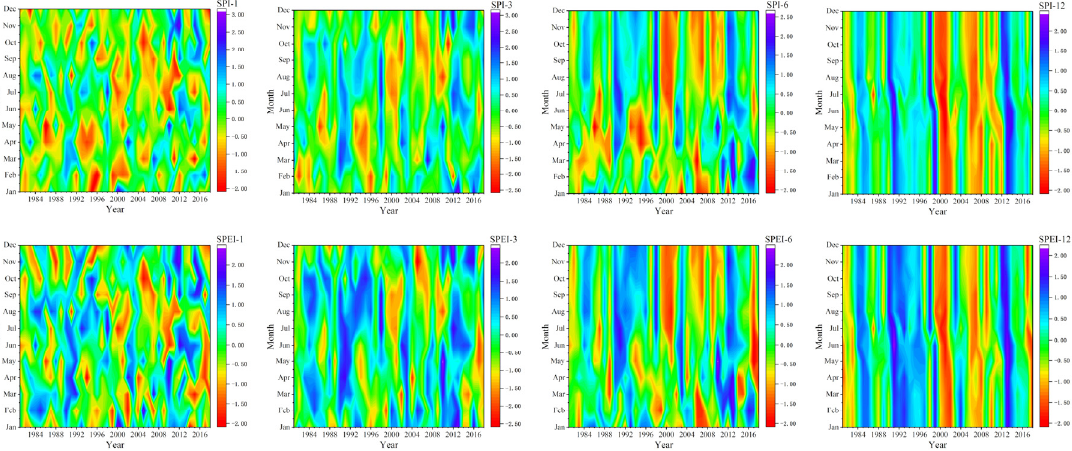
Figure 3. Monthly variations in the SPI and SPEI at 1-, 3-, 6-, and 12-month timescales in Inner Mongolia during 1981–2018.